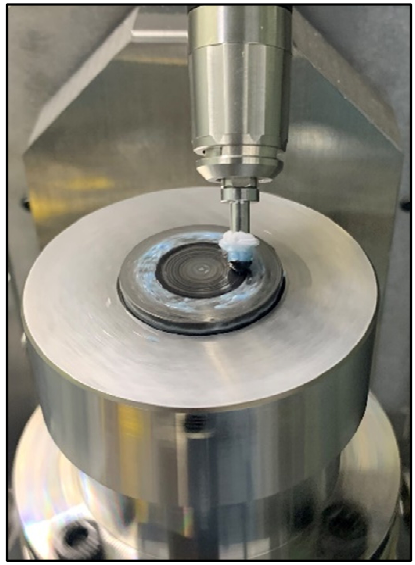
Figure 9. Ring experiment of spherical polishing tool.